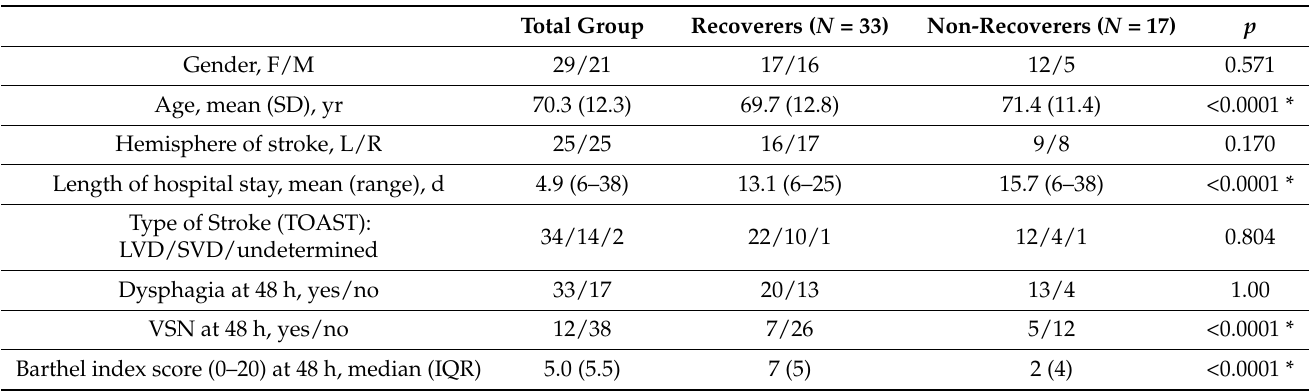
Table 1. Patient characteristics of the total group ( N = 50, second column), and subgroups (right-hand columns) in relation to spontaneous neurological upper limb motor recovery after stroke.